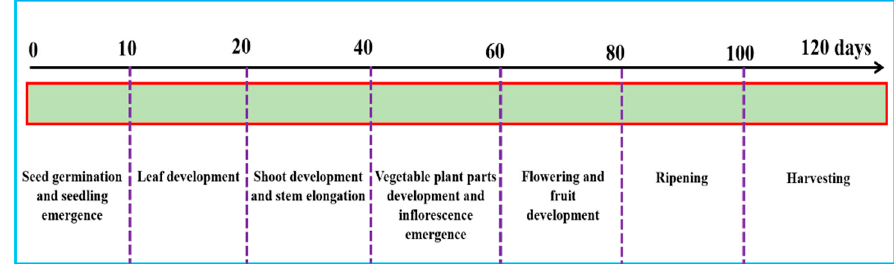
Figure 1. A diagrammatic overview of the growth stages of mustard (BBCH staging